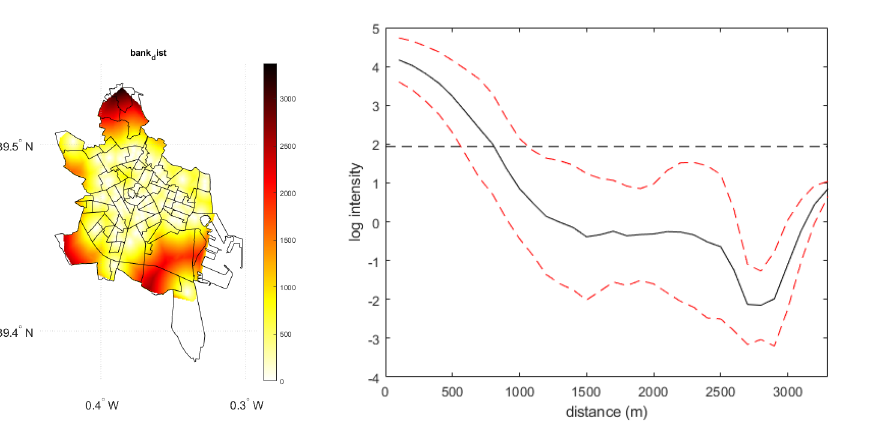
Figure 14. Maps of fixed effects and empirical relationship between distance-based fixed effects (banks) and the log spatial